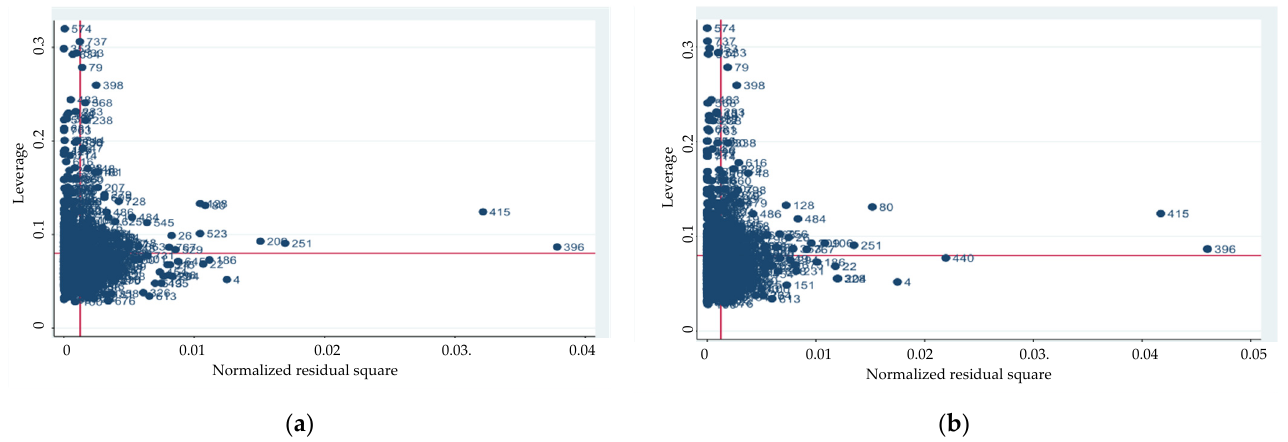
Figure 2. Leverage-versus-residual-squared plot: ( a ) for social performance; ( b ) for technical perfor- mance.